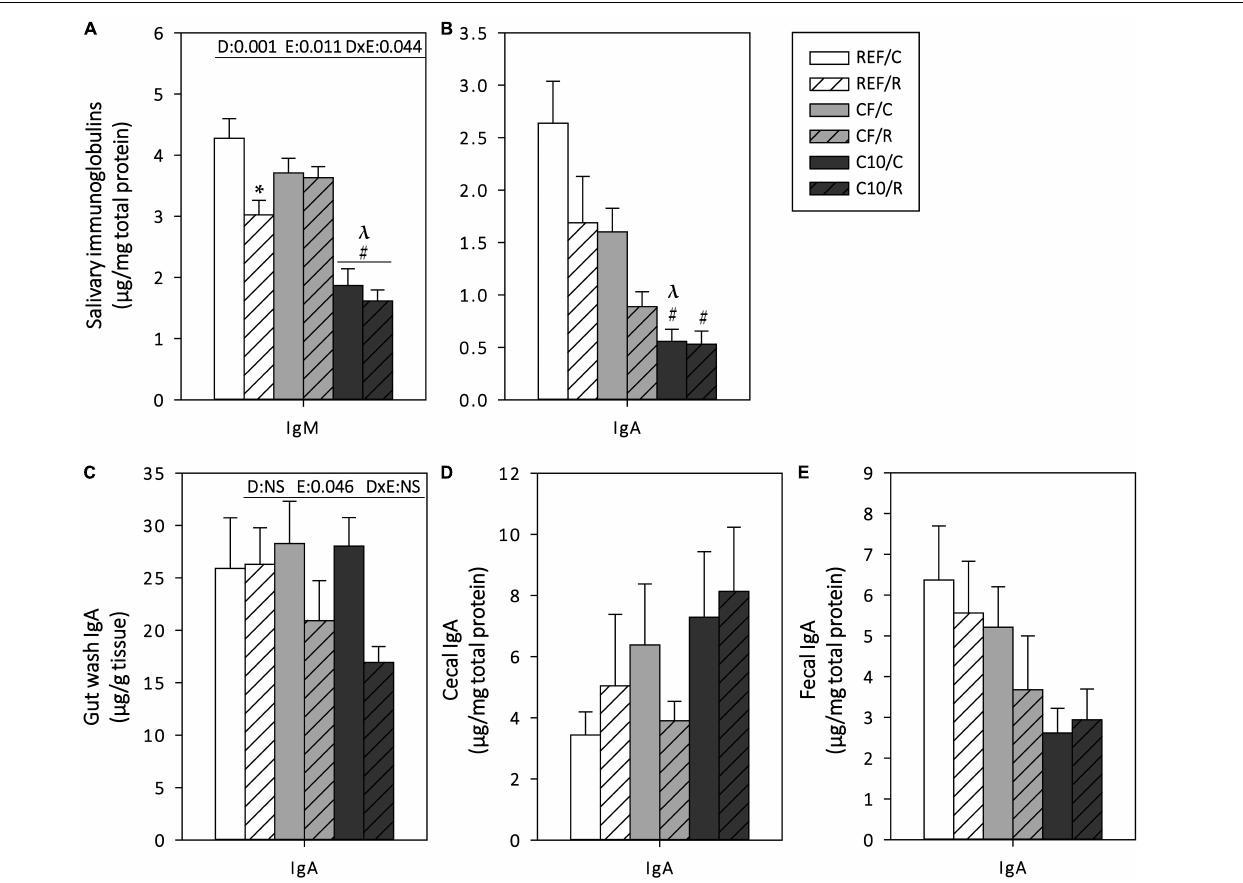
FIGURE 5 | Mucosal immunoglobulins: submaxillary salivary gland IgM (A) and IgA (B) , gut wash (C) , cecal (D) and fecal (E) IgA contents. The control (C) groups are represented by smooth bars and the runner (R) groups by striped bars. REF, reference diet; CF, 5% cocoa fiber-enriched diet; C10, 10% cocoa-enriched diet; NS, no statistically significant differences detected. Data are expressed as mean ± SEM ( n = 8). Statistical differences (two-way ANOVA followed by post hoc Tukey for (A,C) and Kruskal-Wallis followed by Dunnet’s test for (B,D,E) : * p < 0.05 vs. the sedentary group in the same dietary group; # p < 0.05 vs. the same exercise condition in the REF diet; λ p < 0.05 vs. the same exercise condition in the CF diet. The inset table shows two-way ANOVA results when applied (D, diet; E, exercise, DxE, interaction between diet and